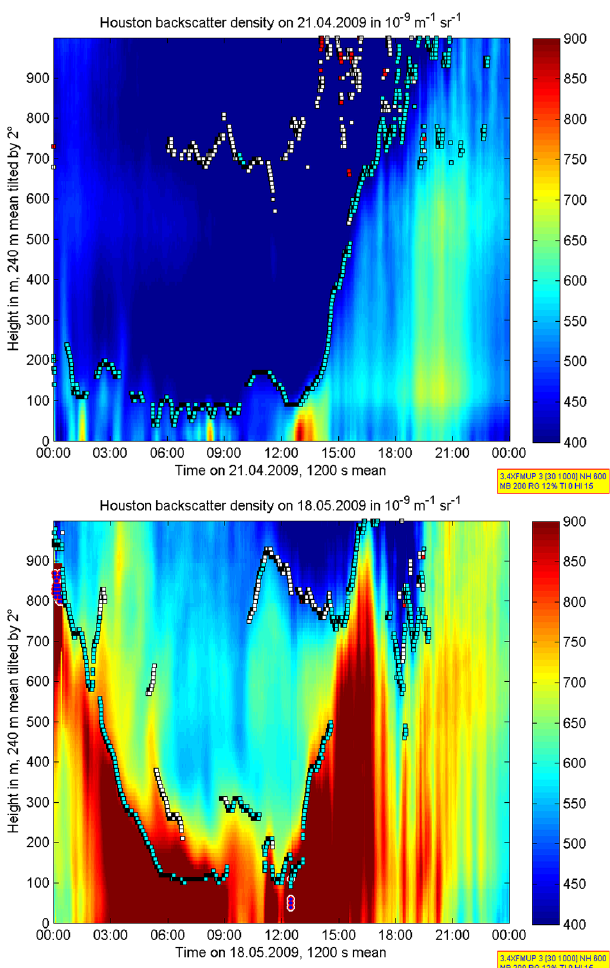
Fig. 11. Timeseries of lidar aerosol backscatter on 21 April 2009 (top) and 18 May 2009 (bottom) measured by a